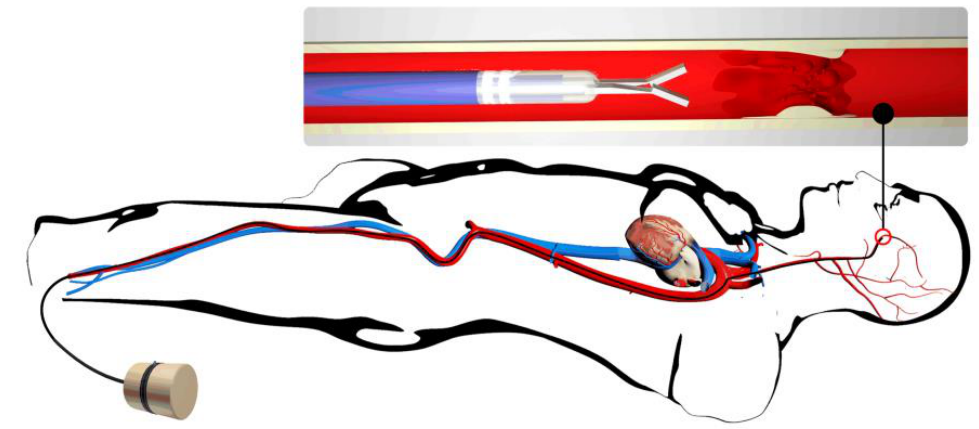
Figure 1. Working schematic of scissor-type micro-stirrer in interventional therapy.